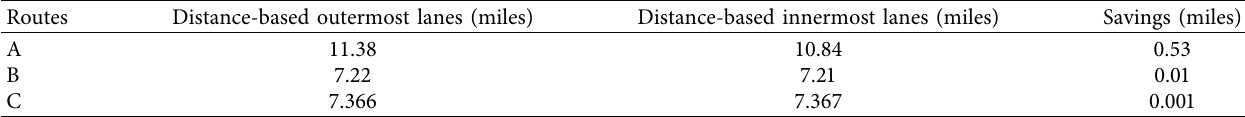
Table 1: Summary for routes A, B, and C.